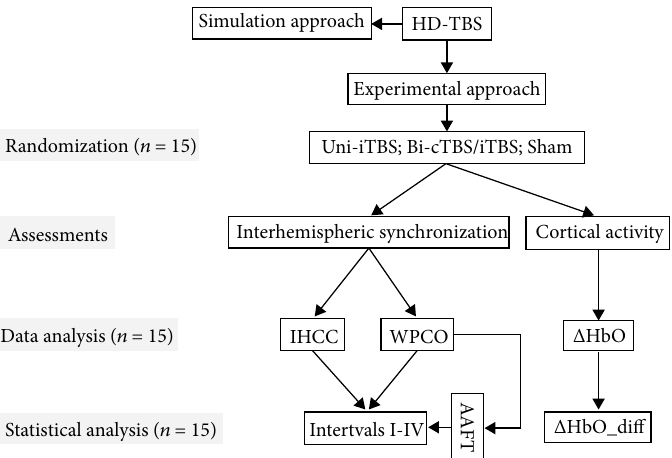
Figure 2: Data analysis fl